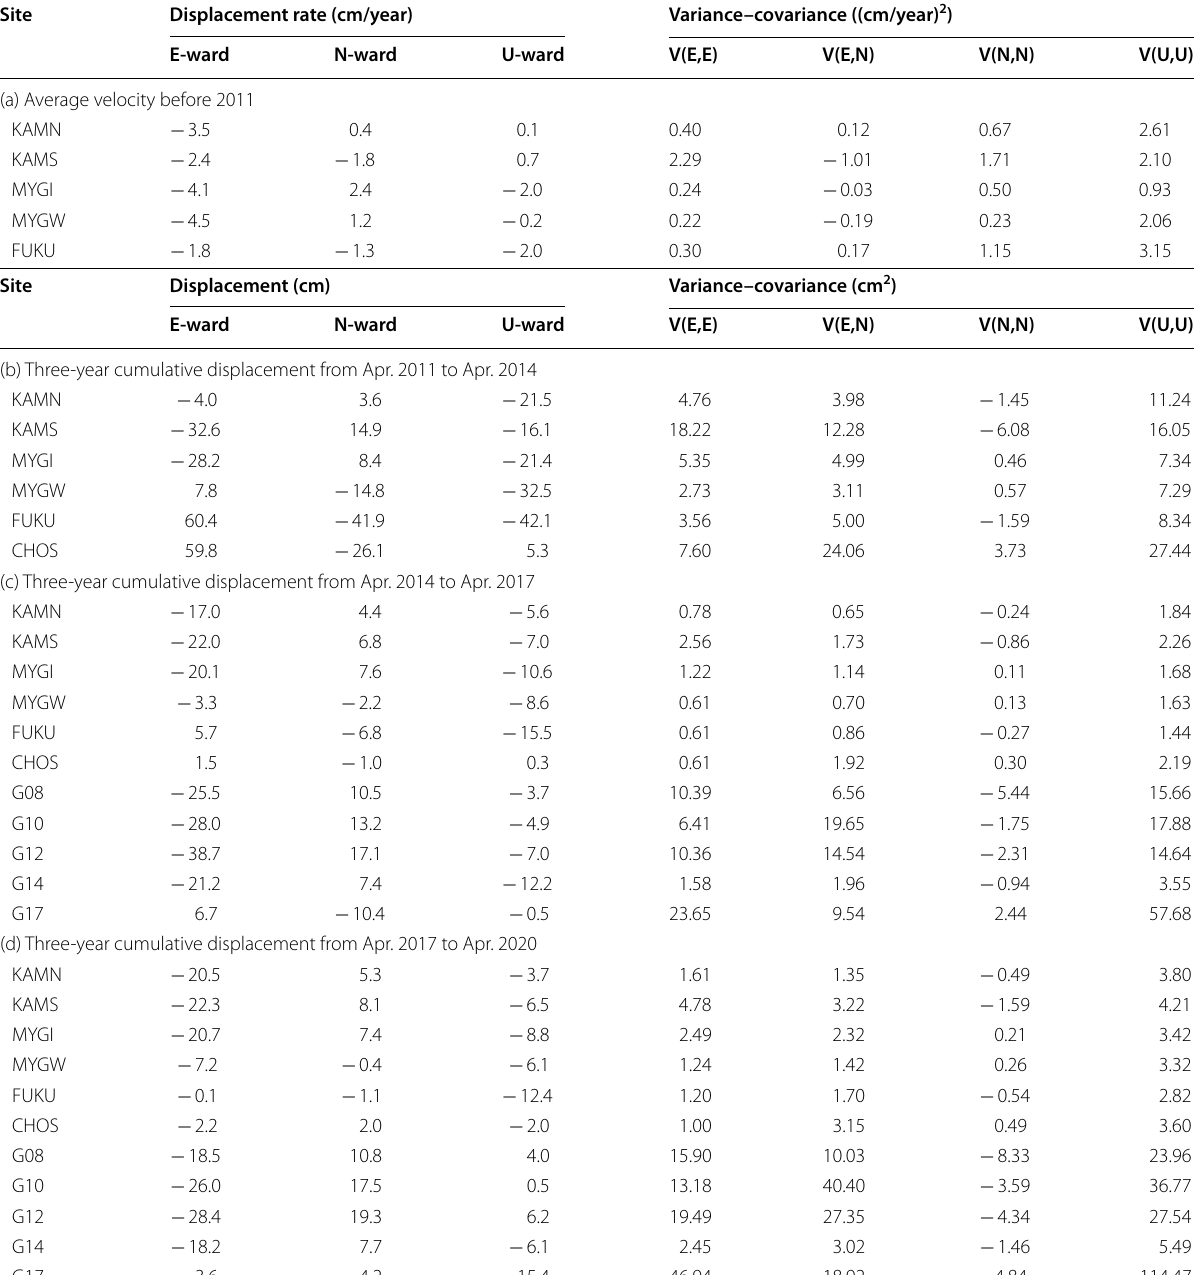
Table 2 Displacements with respect to the Okhotsk plate from the fitted curves with variance‑covariance information